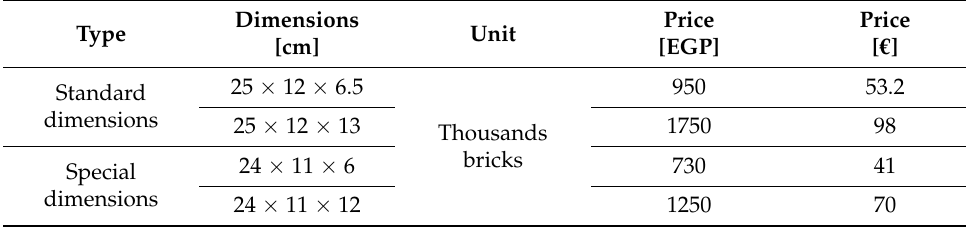
Table A1. Standard dimensions and prices of bricks used in Egypt.